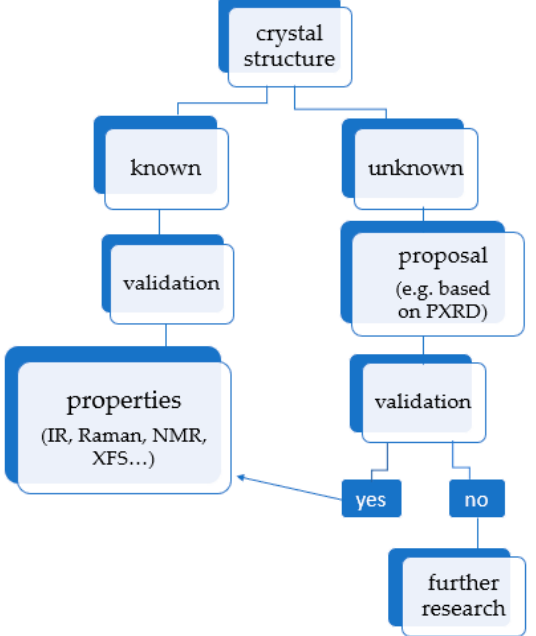
Figure 2. Possible options in the area of periodic density functional theory (DFT) calculations for crystals. Once the crystal structure is obtained and validated, it can be used to calculate other properties, such as thermodynamics or spectroscopic data. XFS stands for X-ray fluorescence.